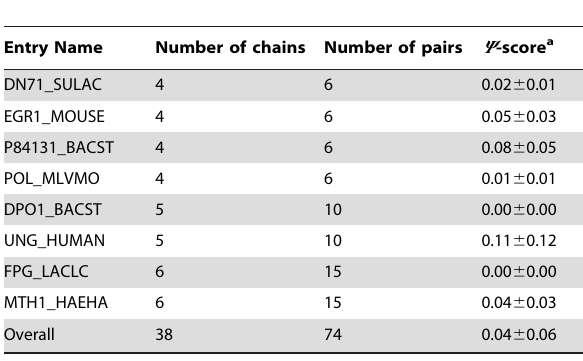
Table 4. Performance on identical protein using different native